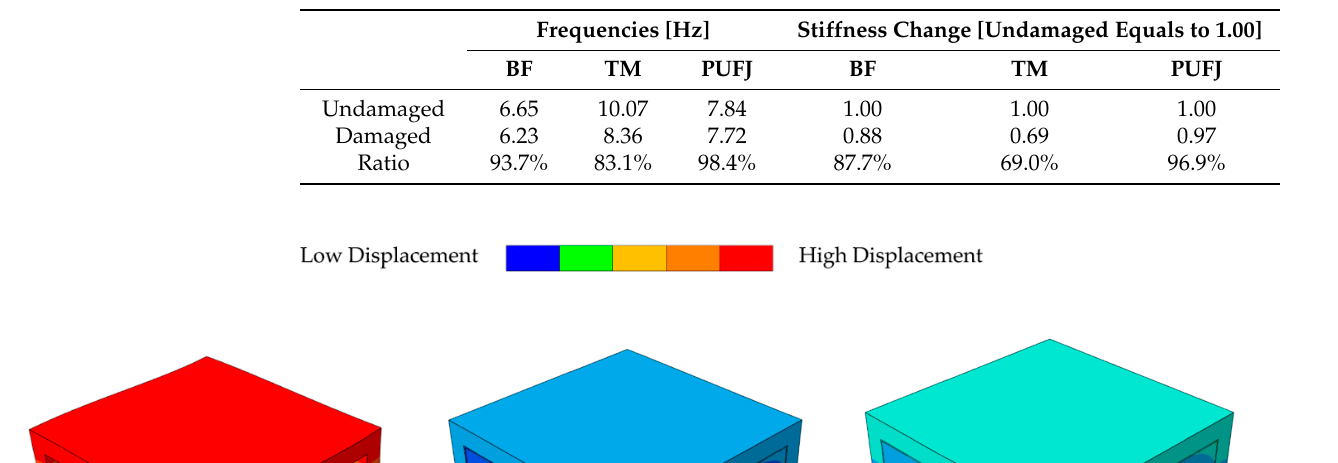
Table 2. Frequency and stiffness changes of the buildings.